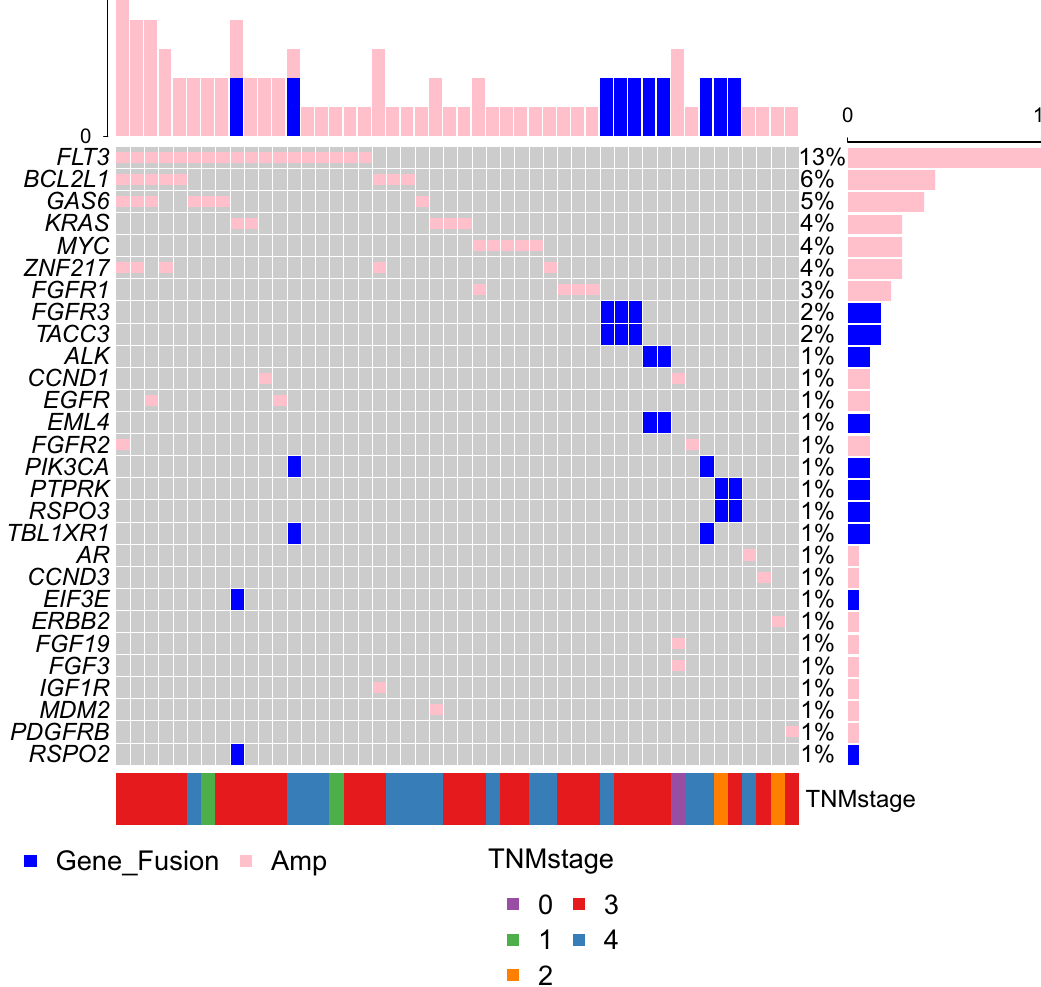
Figure 8. Oncoplot of all genes in which either gene fusion or copy number variation (CNV) was identified. This figure shows the list of genes arranged based on the total number of variants in each gene and the percentage of each gene, which is the ratio of tumor samples with this genetic alteration to total